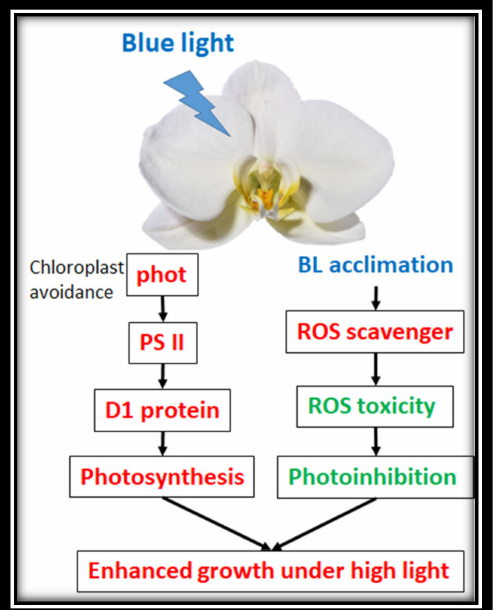
100 µ mol m 2 s − 1 for 12 days had an enhanced chloroplast avoidance and acquired